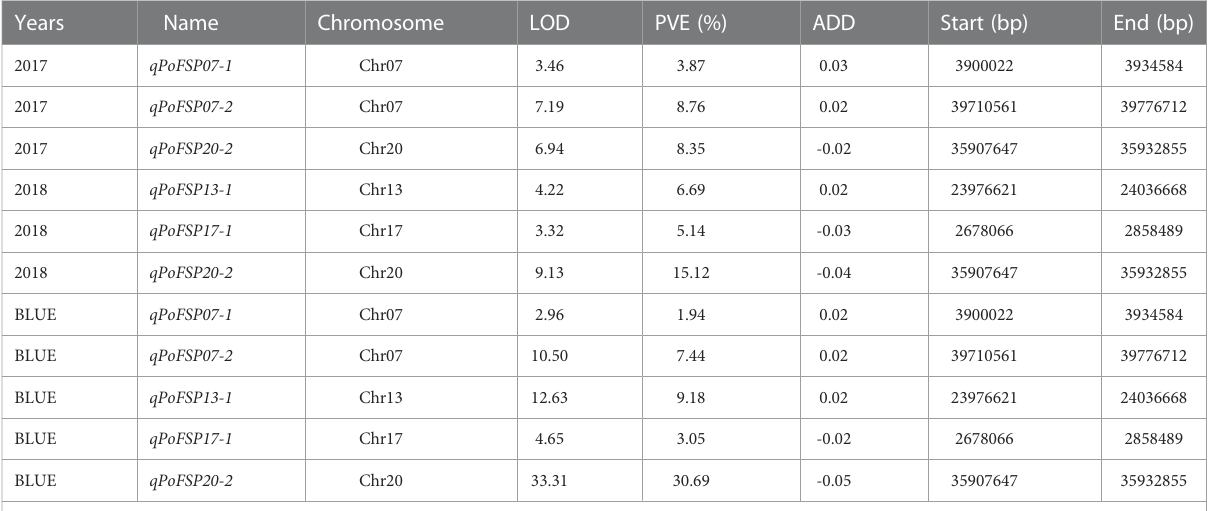
TABLE 1 PoFSP QTLs detected in CSSLs for two or more